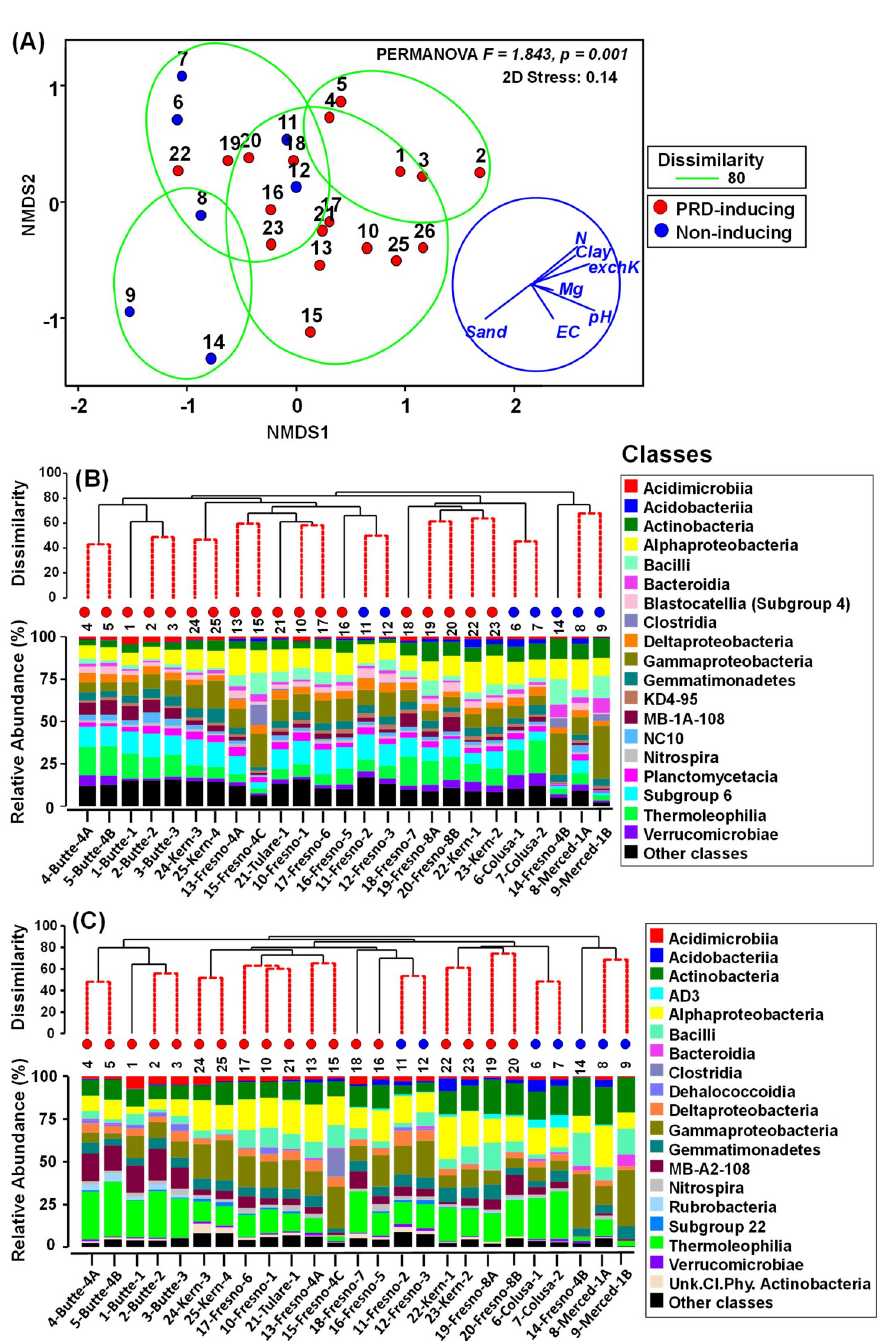
Fig 3. Characterization of soil bacterial community relationships and composition among PRD-inducing and non-inducing soils. (A) Non-metric multidimensional scaling (NMDS) ordination of soils based on Bray Curtis dissimilarity matrix (with overlays of hierarchical clustering at dissimilarity levels of 80% delimited by green lines and physicochemical vector relationships); (B) hierarchical clustering of soils based on BC-dissimilarity and class-level bacterial community composition of V4 amplicons; and (C) hierarchal clustering of soils based on BC-dissimilarity and class-level bacterial community composition of V5-V7 amplicons. Soils are identified by number or by number and county-site, as in Table 1. “Unk.Cl.Phy. Actinobacteria” represents ASVs classified only to phylum Actinobacteria. The BC-dissimilarities were based on cumulative sum scaling (CSS) normalized, square root-transformed counts of bacterial ASVs identified from rRNA gene amplicons in different